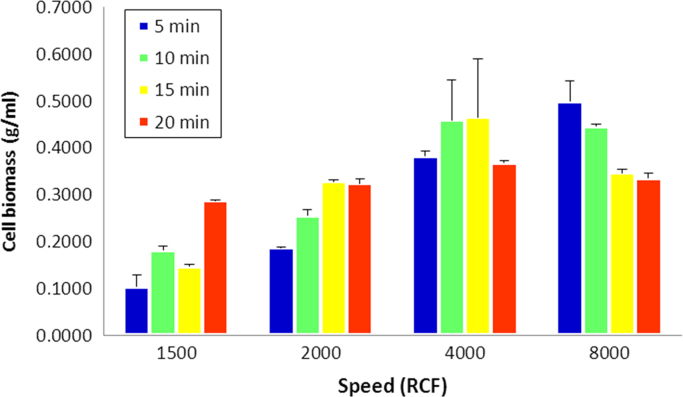
Graphical presentation of the results obtained from centrifugation studies. Data are presented as average yield of cell biomass in gram per ml of culture broth.